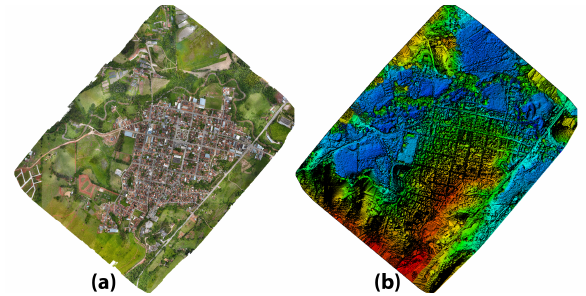
Figure 3. Processing Products: in (a) o Ortophoto mosaic and (b) DSM.